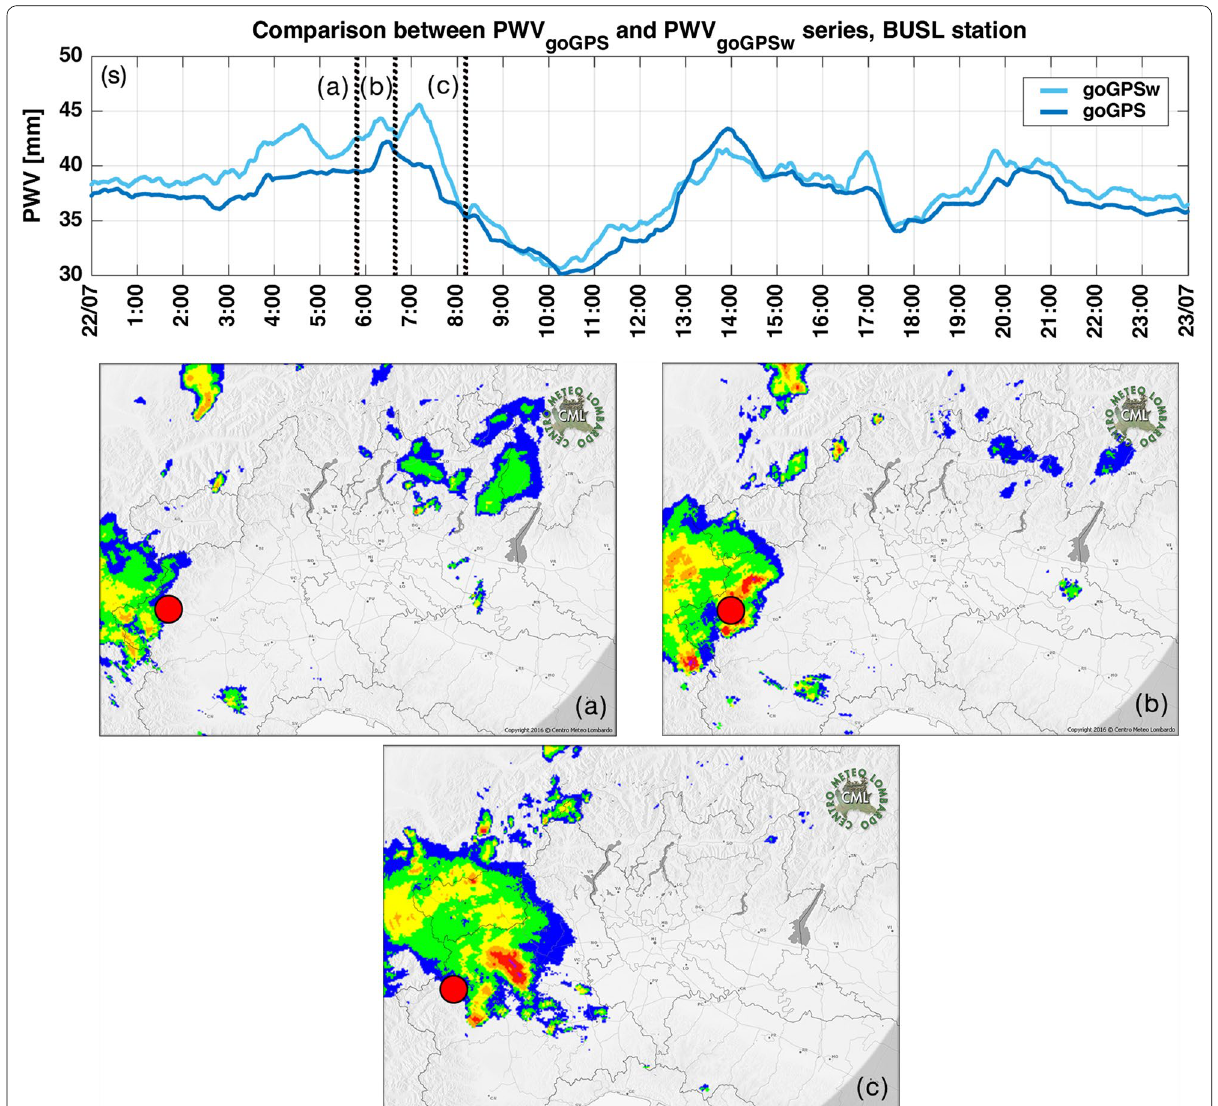
Fig. 8 In the subfigure(s), the BUSL station PWV goGPS and PWV goGPSw time series. On the bottom, the three radar images corresponding to a the epoch when the precipitation starts passing over the station, b to the epoch when it completely surrounds the station, and c to the epoch when it starts leaving the